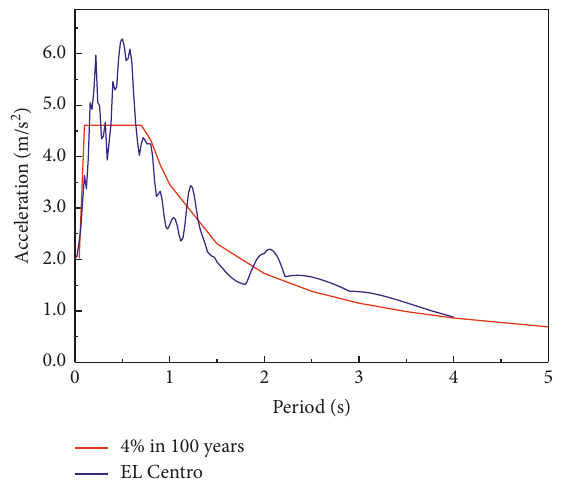
Figure 20: Comparison of the acceleration spectrum for the chosen earthquake data and the Chinese seismic code